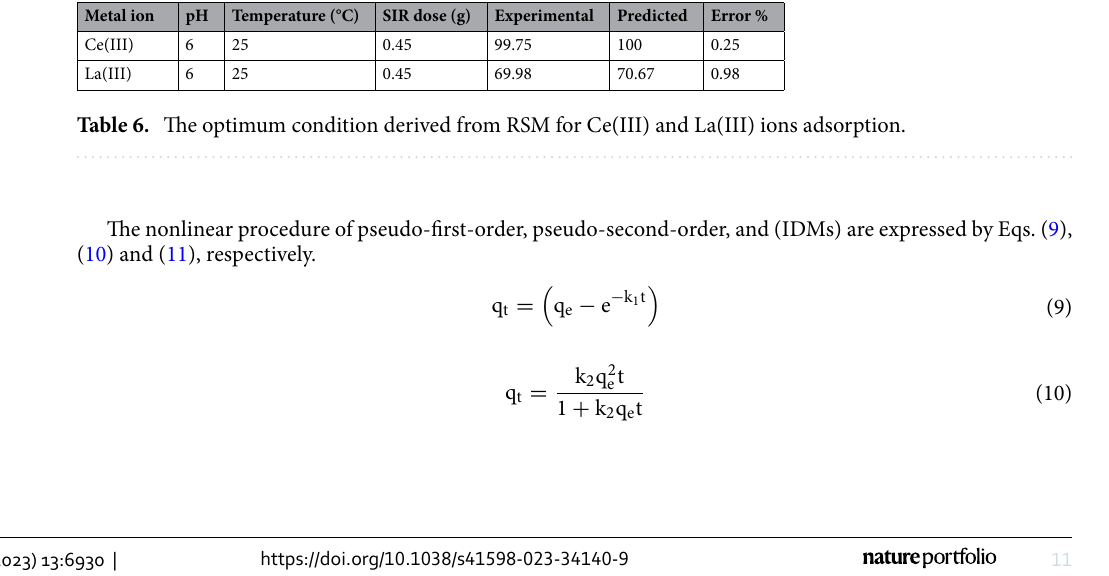
Figure 9. 3D curves of the combined effect of pH and SIR dose on the percentage adsorption of ( a ) Ce(III) and ( b ) La(III) (primary metal ions concentration 200 mg L −1 , temperature = 35 °C and time 180 min). Metal